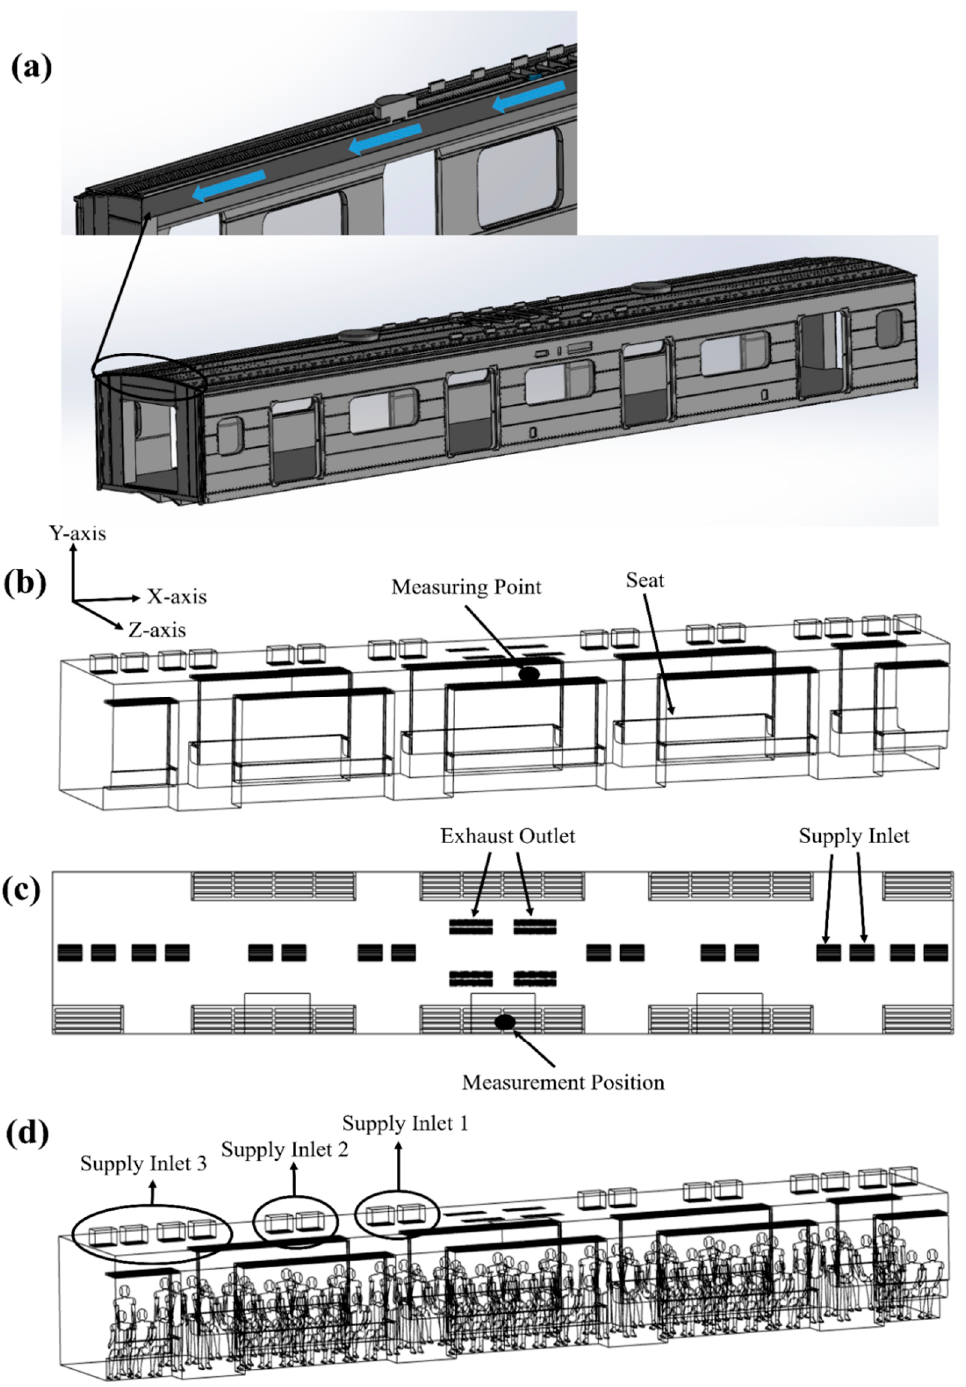
Figure 1. Schematic of a subway cabin. ( a ) HVAC air supply duct; ( b ) simplified geometry of the supply inlets and exhaust outlets; ( c ) positions of the supply inlets and exhaust outlets (top view); and ( d ) supply inlet groups.